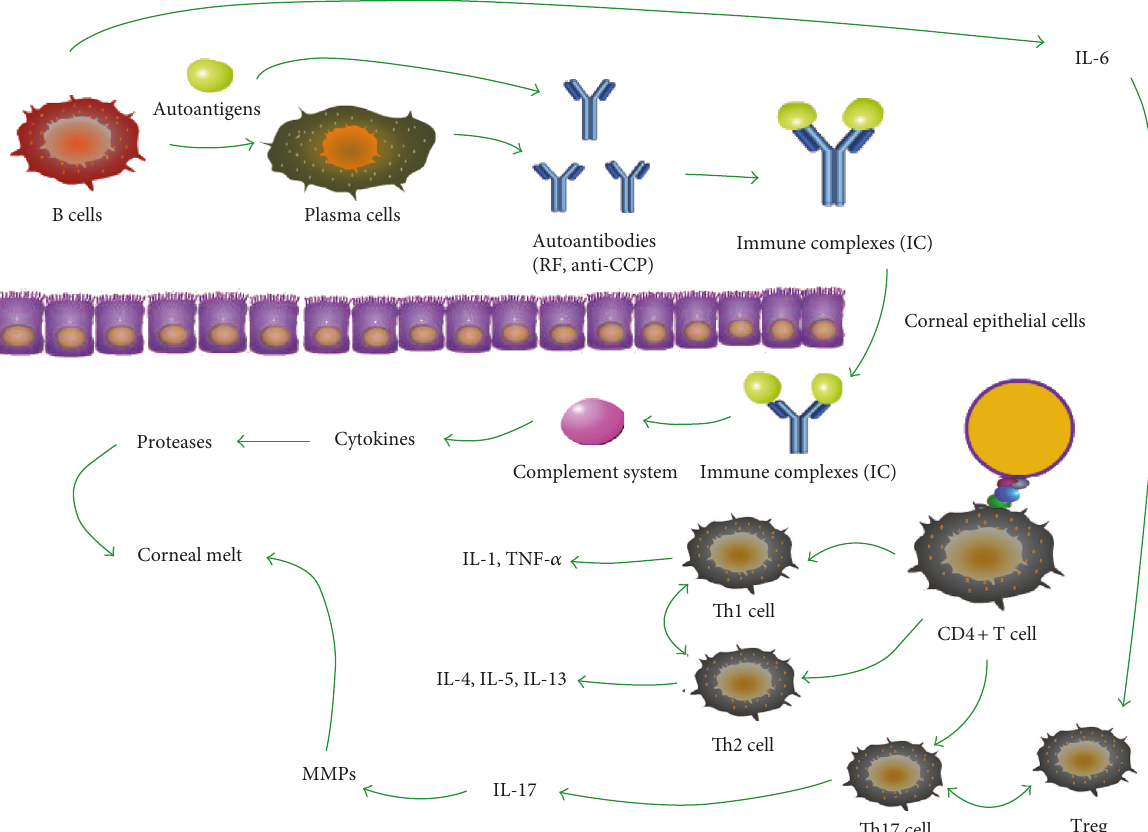
Figure 1: Research suggests that both humoral and cellular immunity are associated with the pathogenesis of autoimmune systemic diseases [7, 8]. Autoantigens lead to the activation of antigen-speci fi c T and B cells. Then, immune complexes and cytokines are formed. It is collagenases and other proteases that eventually contribute to damage in the joints and on the ocular surface [7, 8,